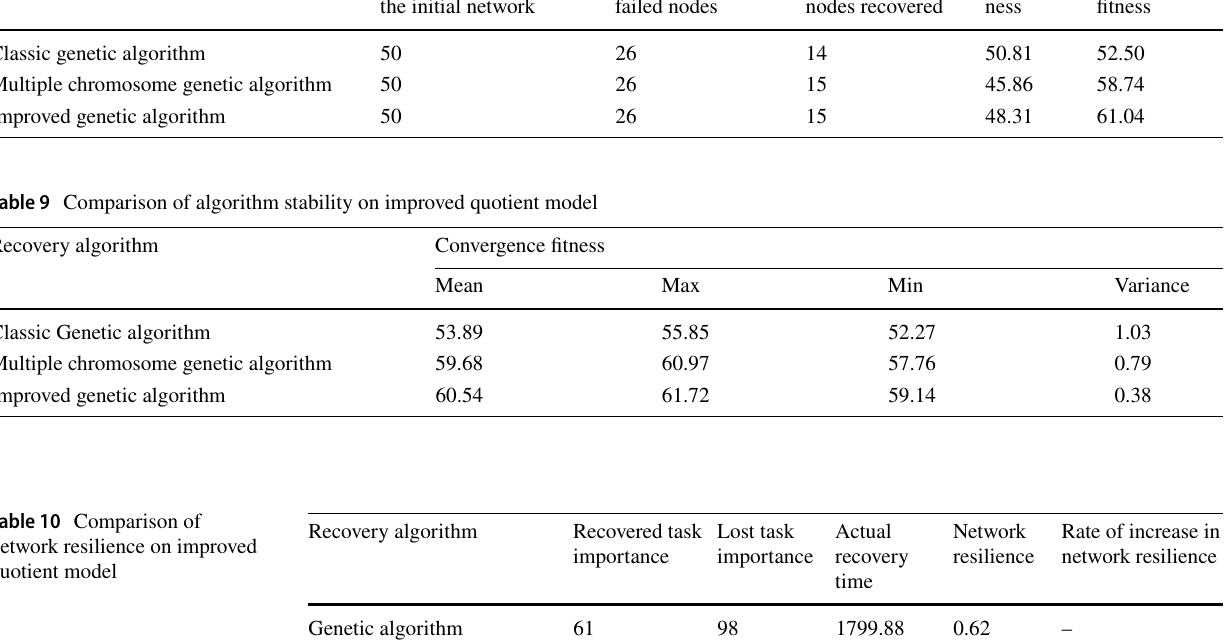
Table 8 Comparison of recovery algorithm results on improved quotient model Recovery algorithm